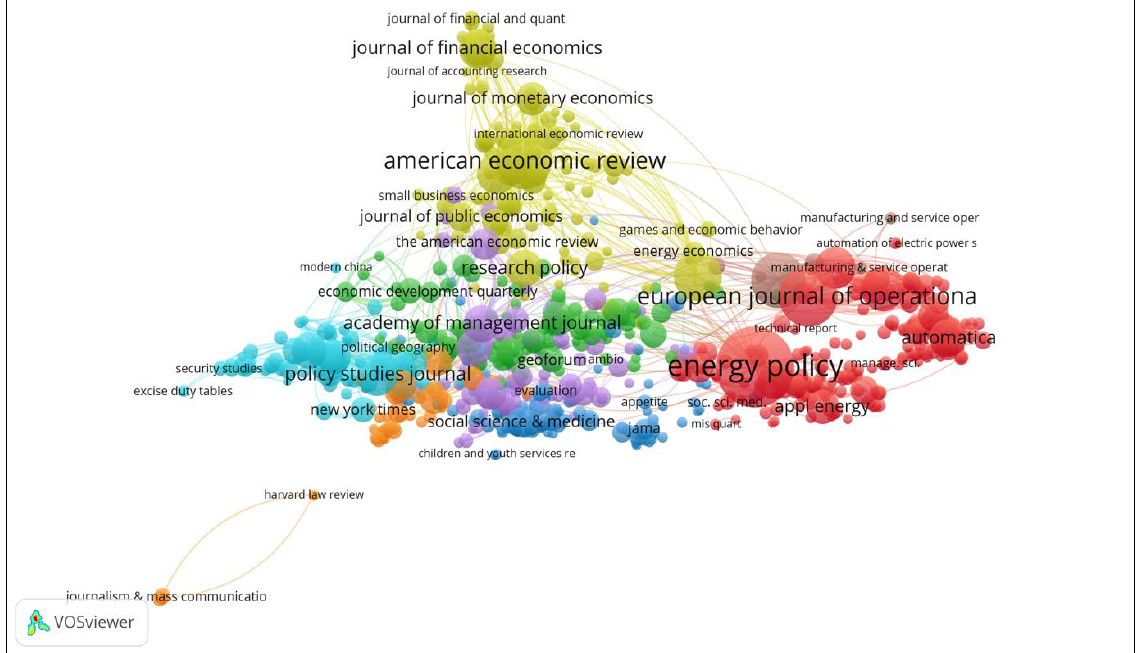
Figure 7. Co-citation network of journals publishing theory-related policy research. Note: The figure shows how commonly journals (with at least ADD citations) are cited together in publications. Nodes denote journals, and their linkages convey co-citation relationships. Larger nodes present journals with more citations. Link strengths indicate the frequency with which they are co-cited. Co-cited Journals often are clustered together in nodes of the same